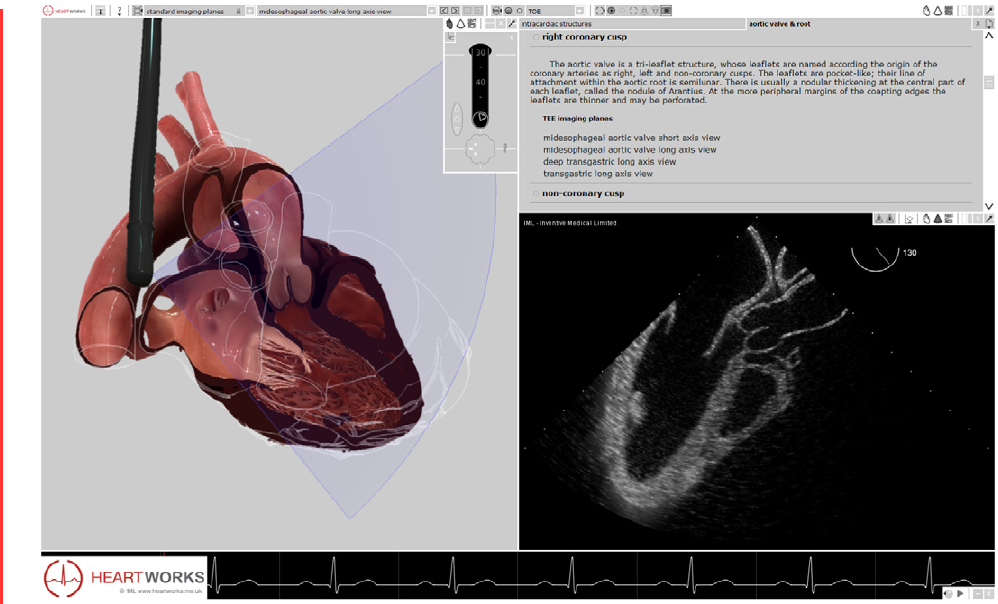
Figure. 7 Graphical user interface. The 3D model of the heart, ultrasound image and explanatory text may be displayed in any configuration and any combination on the screen.